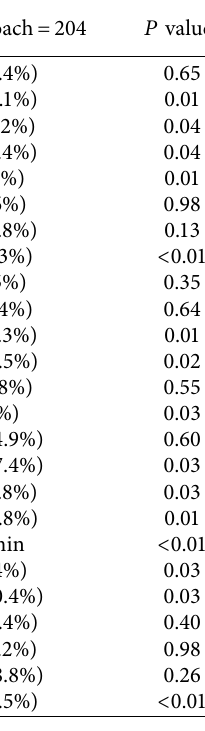
Table 1: Demographics and clinical characteristics of patient population of the study by surgical